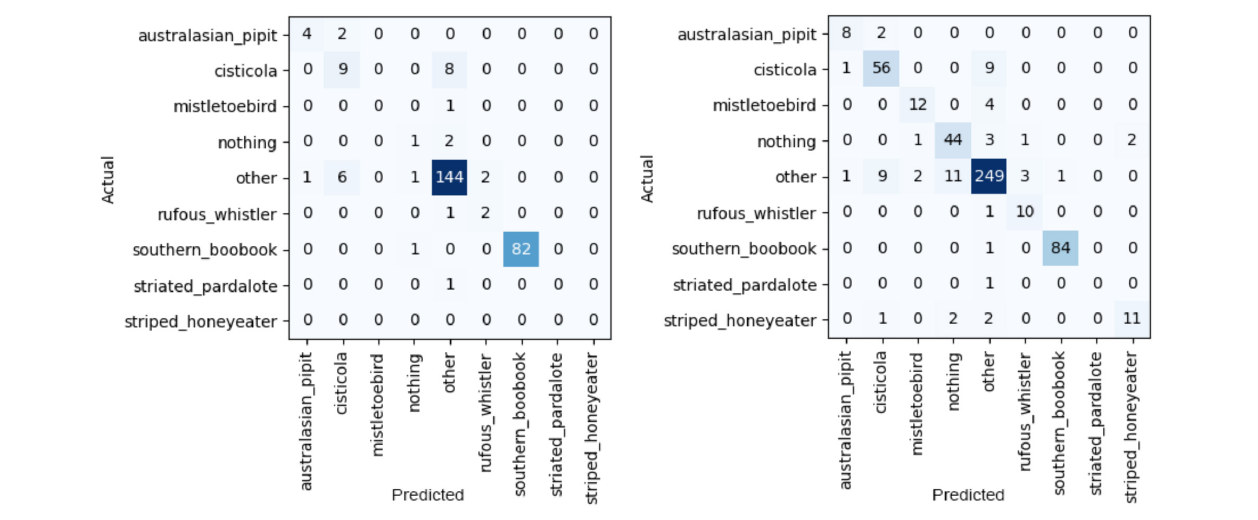
FIGURE 5 | Confusion matrix for T1 (left) and T8